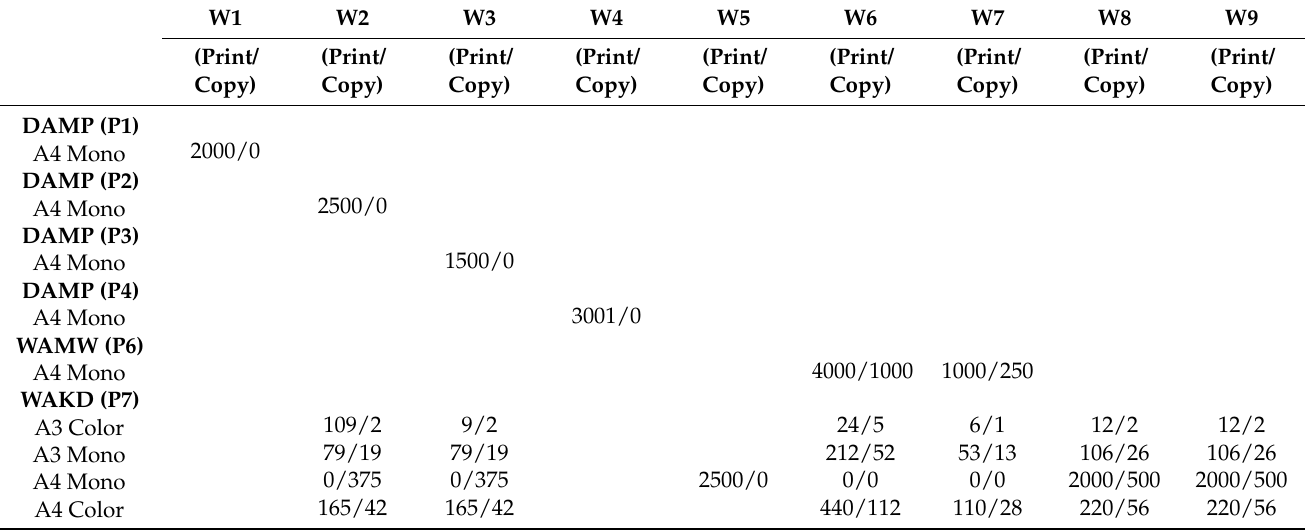
Table 7. REF + EC scenario results—printed/copied page volume of each printing